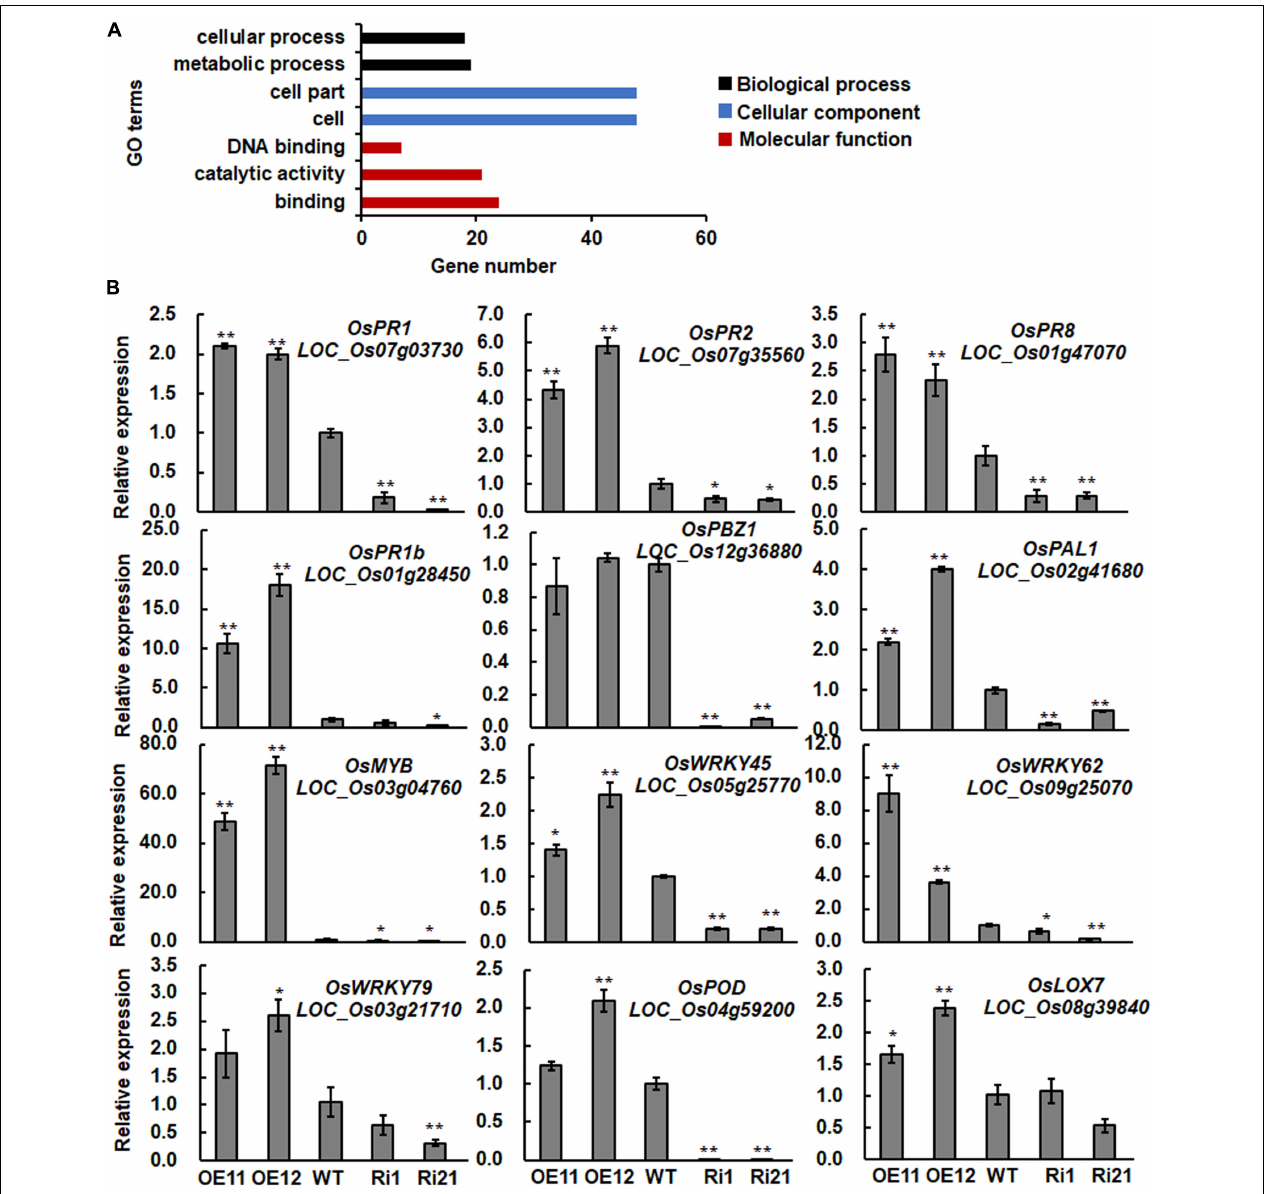
FIGURE 3 | (A,B) Differentially expression of selected defense- and signaling-related genes in ONAC066 -OE and ONAC066 -Ri plants. Data represented are the means ± SD from three independent experiments and **/* indicated significant difference at p < 0.01 and p < 0.05 levels, respectively, by Student’s t -test, in comparison to